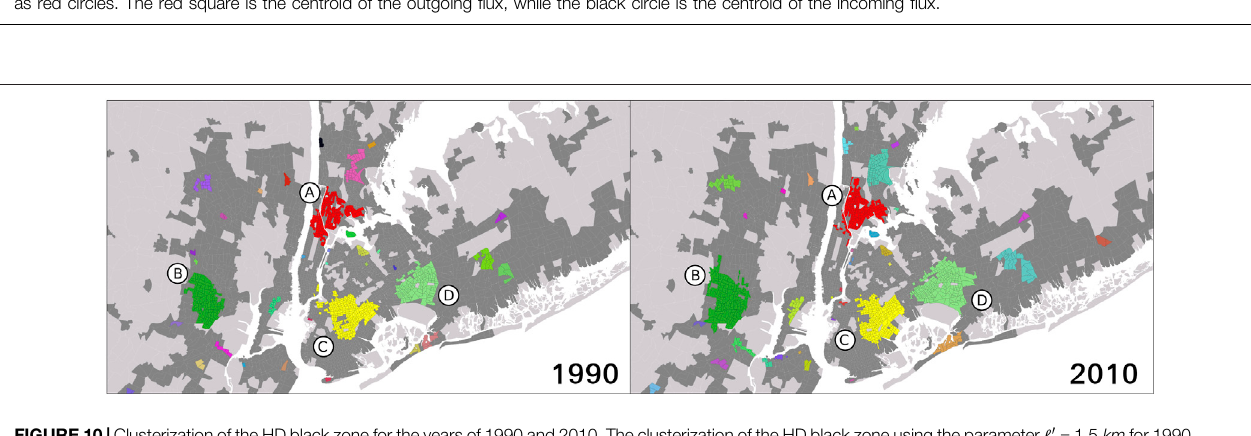
FIGURE 10| Clusterization of the HD black zone for the years of1990 and 2010. The clusterization of the HD black zone using the parameter ℓ ′ (cid:1) 1.5 km for 1990 and 2010. We highlight the four most signi fi cant clusters (A) (in red), (B) (in dark green), (C) (in yellow), and (D) (in light green).